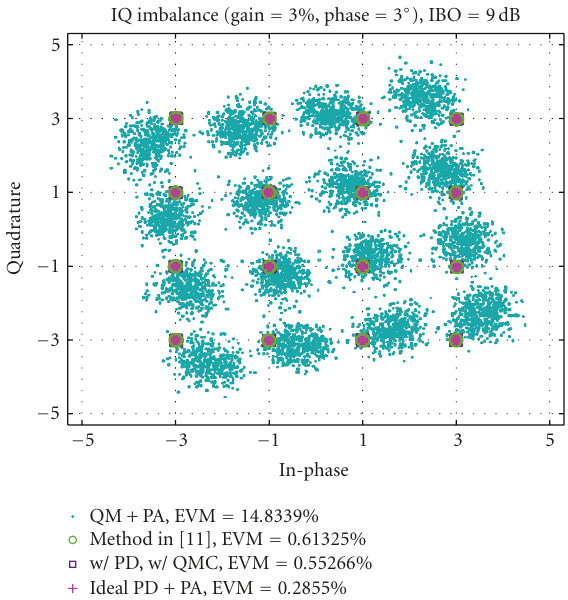
Figure 13: EVM performance of the MOP PD without and with the proposed